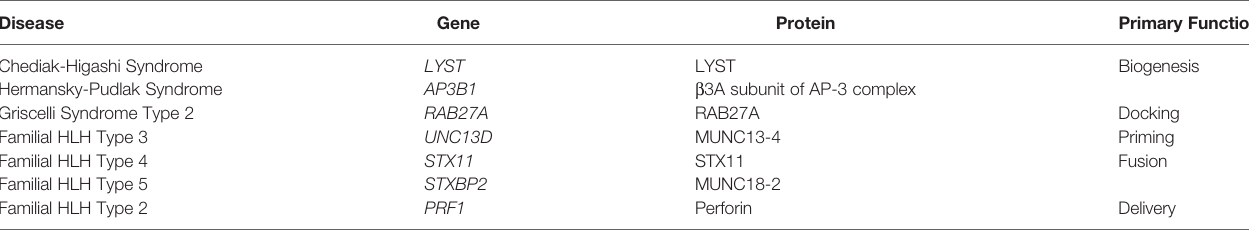
TABLE 1 | Degranulation Pathway Genes in HLH and Related Immune Dysregulation Syndromes. Disease Gene Protein Primary